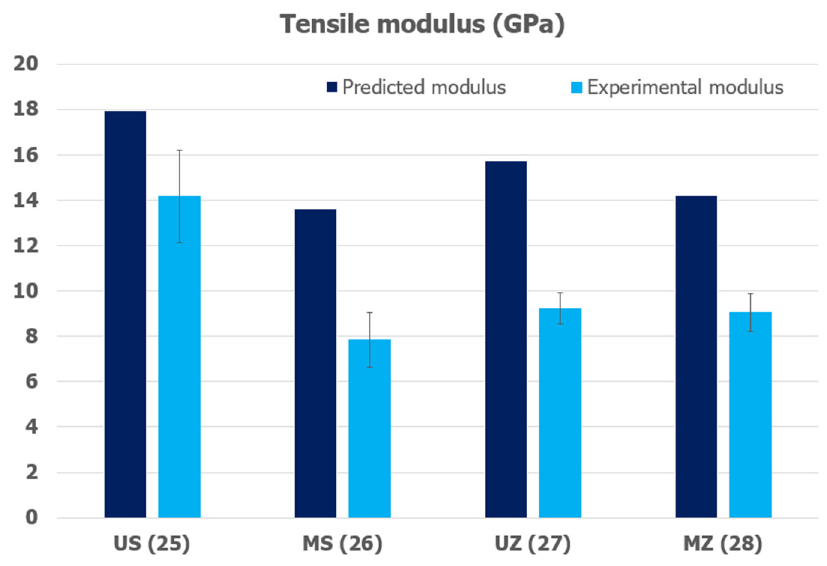
Figure 2. Predicted and experimental axial moduli for the four conditions. M = mercerised, S = silane in hardener, U = not mercerised, Z = no silane in hardener.